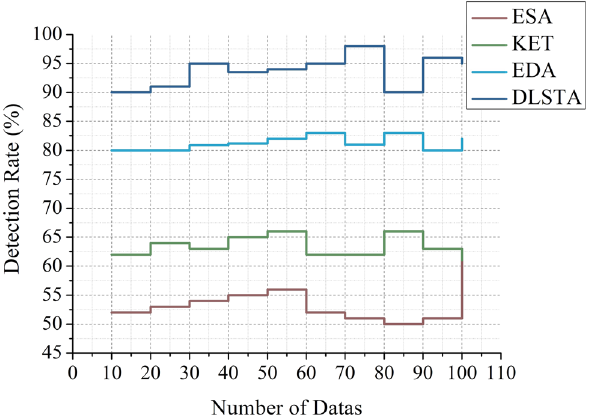
Figure 5: The detection rate of DLSTA.